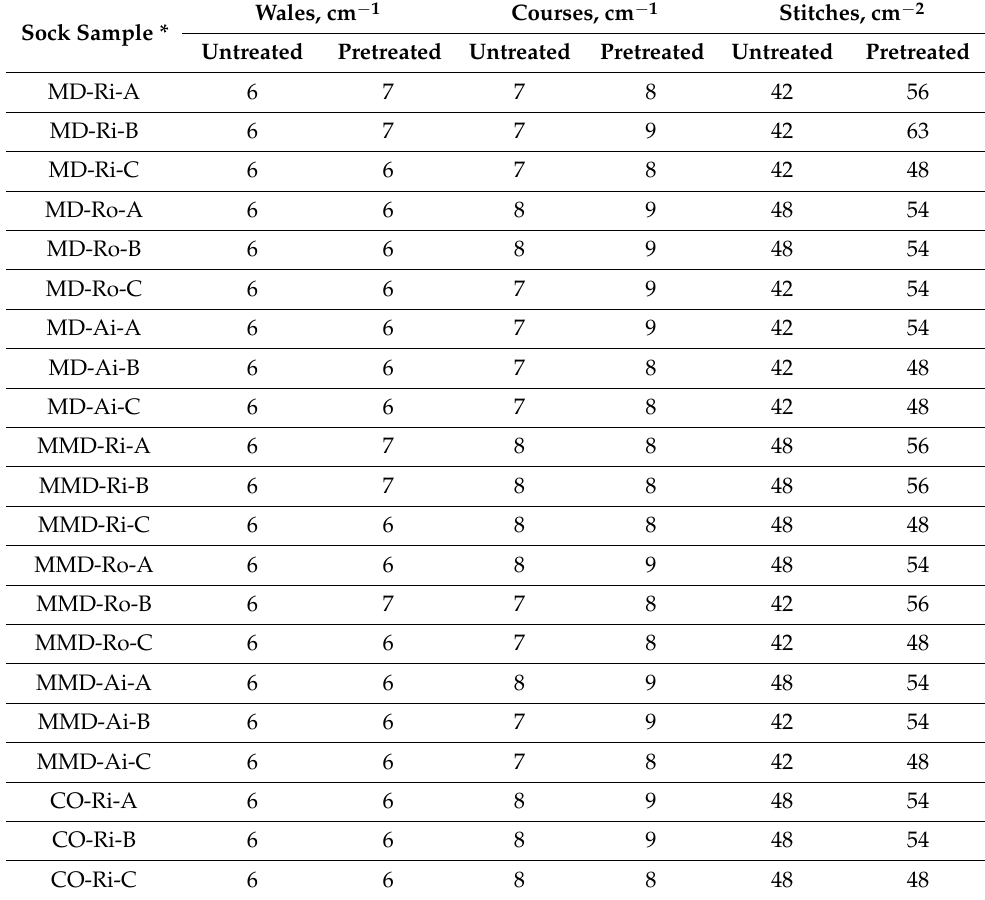
Table 4. The untreated and pretreated sock plain knit samples’ density parameters (number of wales per cm, courses per cm and stitches per cm 2 ) determined before and after five repeated washing and drying cycles of the socks.